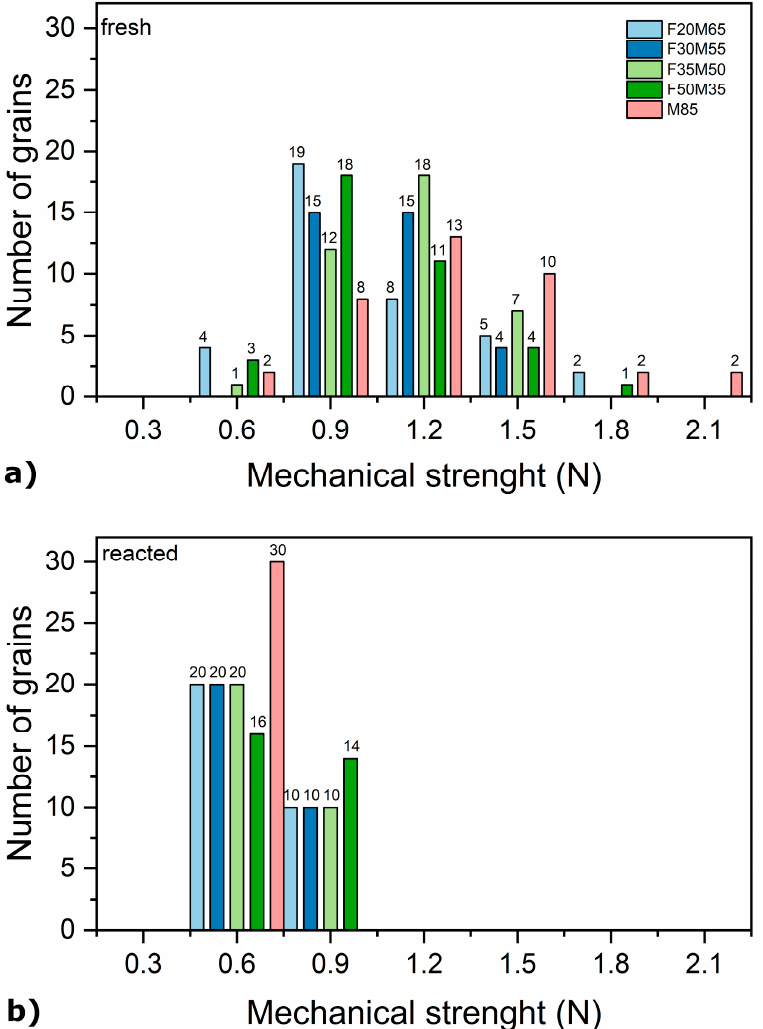
Figure 2. Comparison of crushing strengths obtained for fresh ( a ) and reacted ( b ) OC samples.